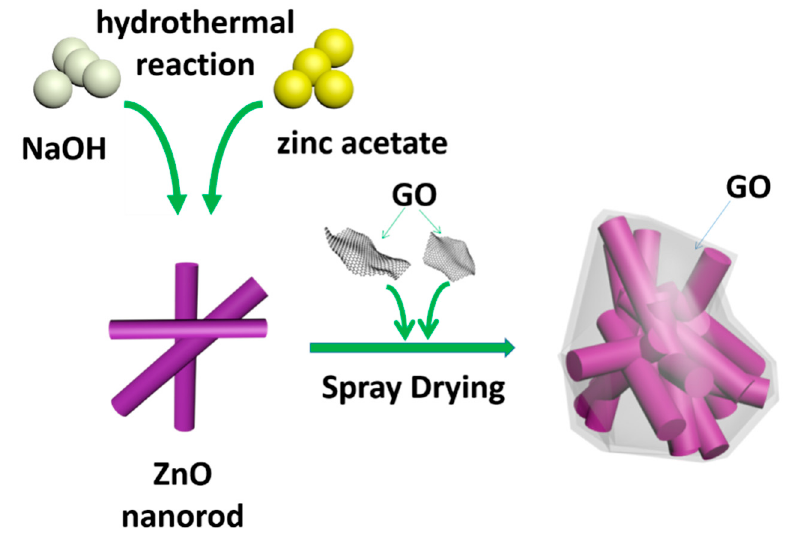
Figure 1. Schematic illustration of the synthesis of the ZnO/graphene composite.